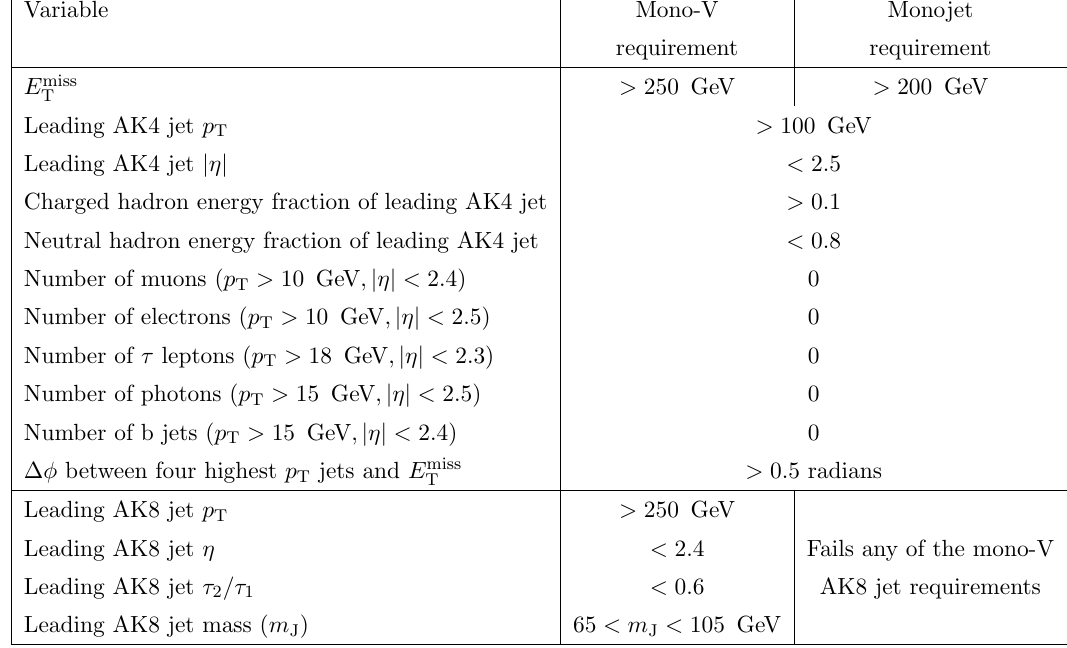
Table 2 . Selection requirements for the mono-V and monojet event